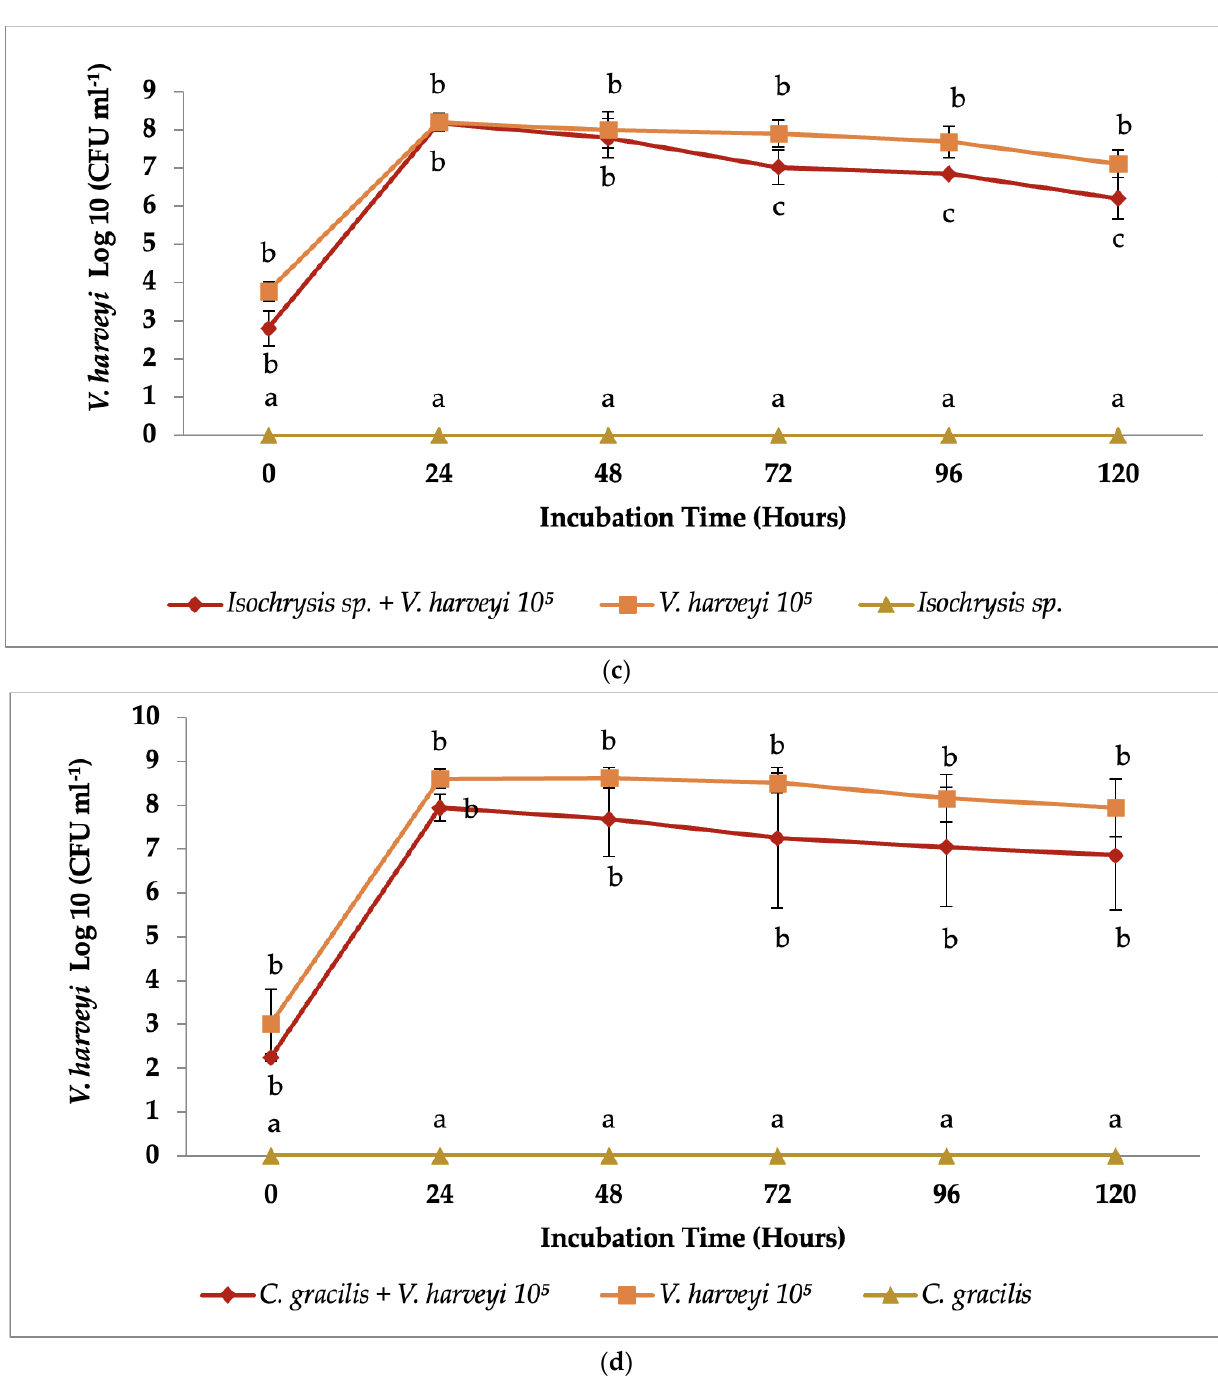
Figure 1. ( a ) V. harveyi concentration was significantly lower ( p < 0.05) at 24–48 h incubation in co-culture assay with N. oceanica as compared to control V. harveyi with no microalgae added. ( b ) V. harveyi concentration was significantly lower ( p < 0.05) at 24 to 72 h incubation in co-culture assay with T. weissflogii as compared to control V. harveyi with no microalgae added. ( c ) V. harveyi concentration was significantly lower ( p < 0.05) at 72 to 120 h incubation in co-culture assay with Isochrysis sp as compared to control V. harveyi with no microalgae added. ( d ) V. harveyi concentration showed no significant difference ( p > 0.05) in co-culture assay with C. gracilis as compared to control V. harveyi with no microalgae added. Note: Values are presented as mean ± SD. Mean values of V. harveyi within the same time (hours) with different lowercase letters are significantly different ( p < 0.05).